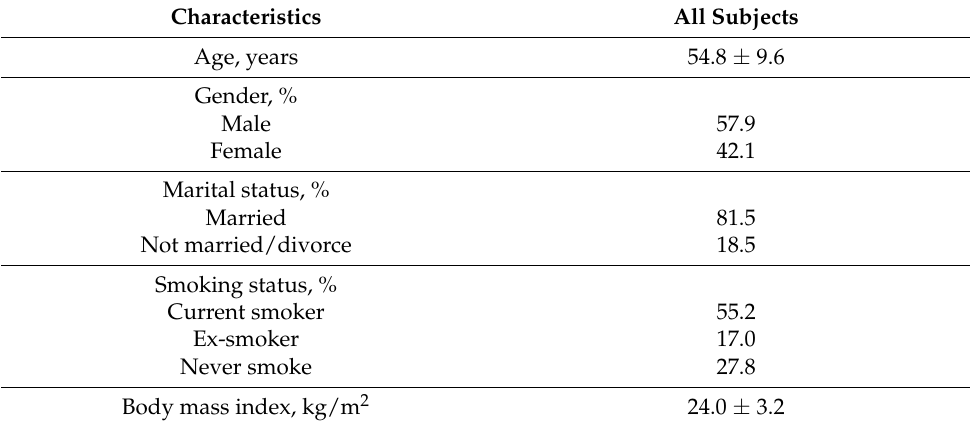
Table 2. Characteristics of the subjects ( n = 259) 1